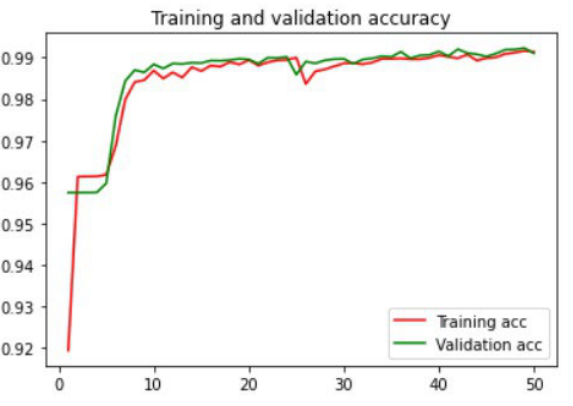
Figure 6. Accuracy of U-NET